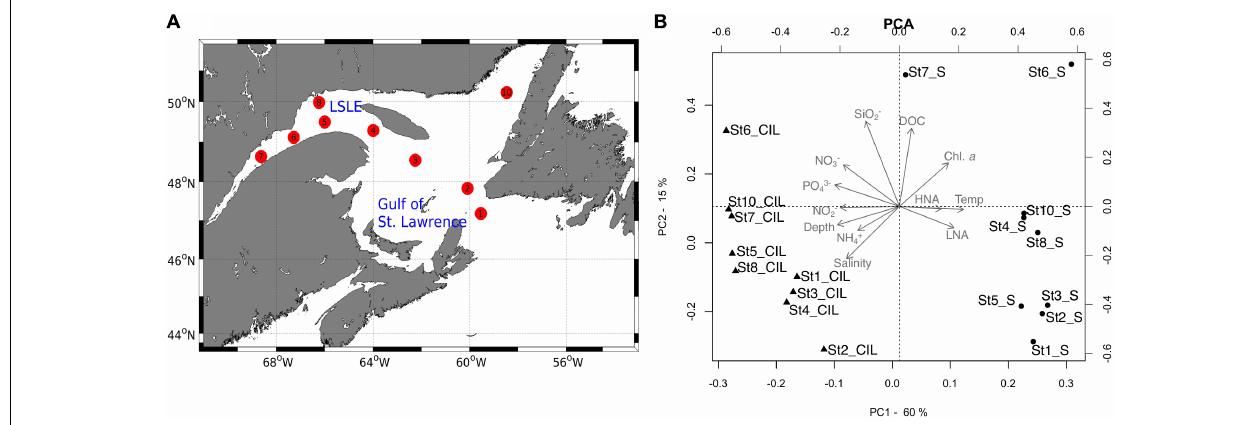
FIGURE 1 | (A) Map of the study area, showing the cruise track of the Maria S. Merian along the Gulf of St. Lawrence (GSL, stations 1–4) and the lower St. Lawrence Estuary (LSLE, stations 5–8, 10). Sampling stations are labeled consecutively as numbered circles (red), in the order of sampling. (B) The results of the principal component analysis (PCA) showing the grouping of the sampling sites in terms of environmental variables. In the plot, sampling sites at the surface (S) are denoted by circles and those at the cold intermediate layer (CIL) by triangles. Gray arrows indicate environmental variables; arrows pointing in the same direction and with a similar length indicate a high-positive correlation with the sampling sites. The station ID and depth of each sampling site are indicated. The two first axes explained 75% of the variance. DOC, dissolved organic carbon; Temp, temperature; NH4-N, ammonium; NO 2 -N, nitrite; NO 3 -N, nitrate; PO 4 -P, phosphate; SiO 2 , silica; HNA, bacterial cells with high nucleic acid content; LNA, bacterial cells with low nucleic acid